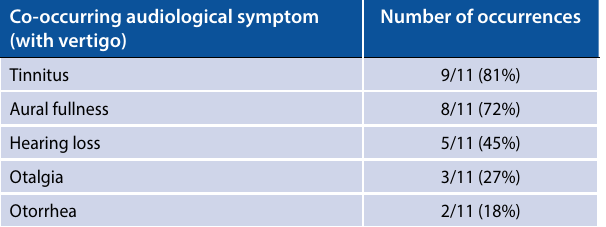
Occurrence in males versus females